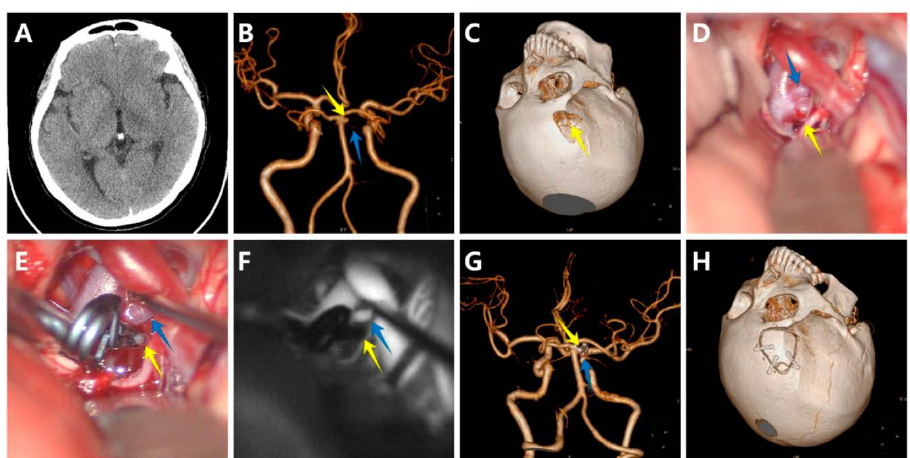
Figure 2. A woman with a saccular aneurysm on the bifurcation of the right superior cerebellar artery (SCA) and the basilar artery (BA). ( A ) The computed tomography scan showed no apparent abnormality; ( B ) The computed tomography angiography (CTA) revealed a 3 mm saccular aneurysm on the bifurcation of the right SCA and the BA; ( C ) Preoperative simulation of the surgical approach; ( D ) The aneurysm, SCA, and BA before clipping; ( E ) The aneurysm, SCA, and BA after clipping; ( F ) Intraoperative indocyanine green videoangiography confirmed no residual aneurysm and patency of SCA and BA; ( G ) Postoperative CTA further demonstrated complete obliteration of the aneurysm; ( H ) The small bone flap. (The yellow arrows show the aneurysm, and the blue arrows show the